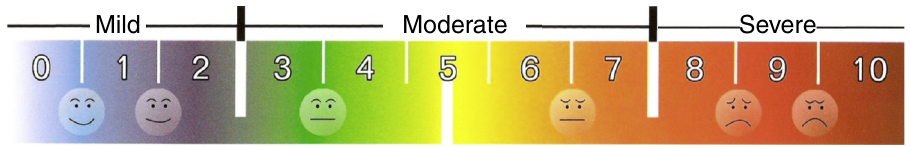
Figure 2 Visual analog